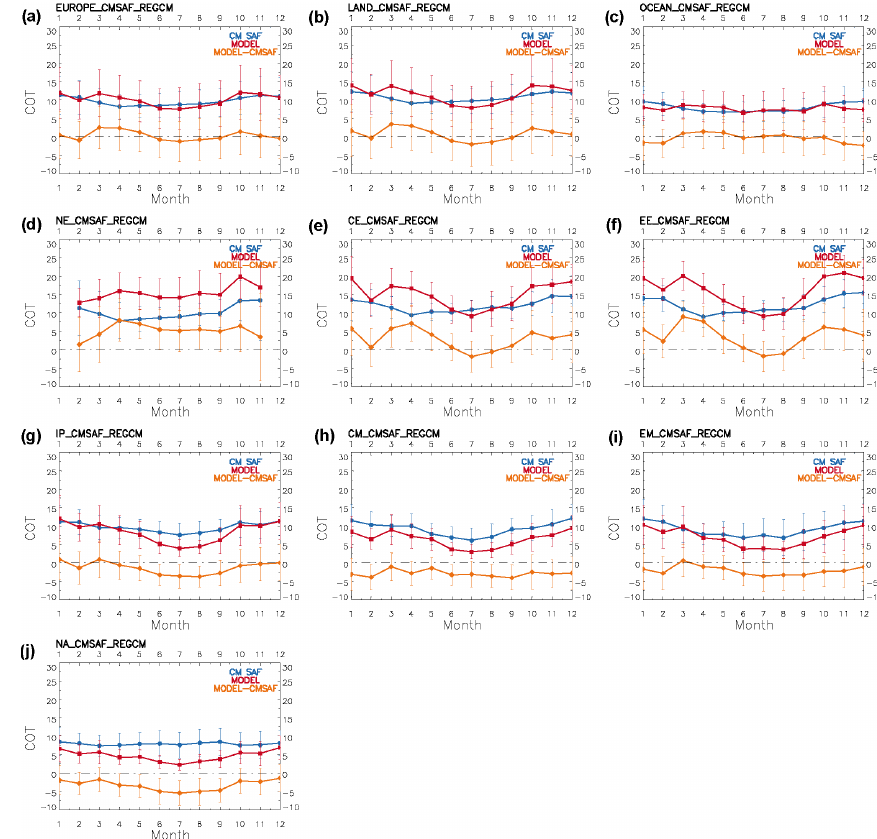
Figure 9. The same as Fig. 3 but for RegCM4 and CM SAF